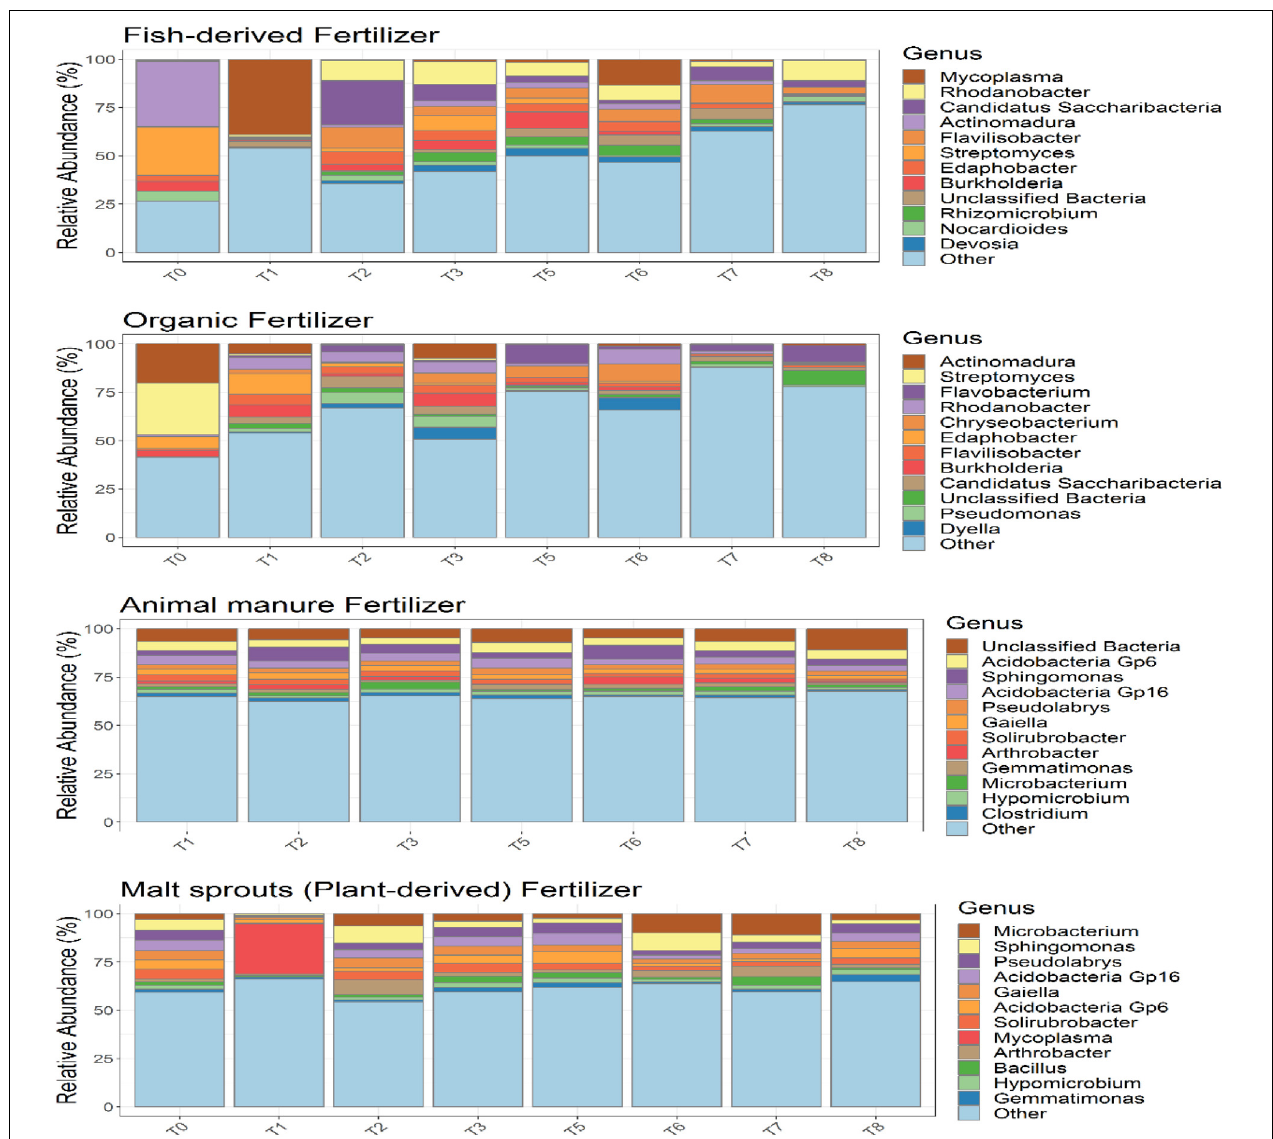
FIGURE 9 | Analysis of the bacterial composition of the different tomato cultivation systems: GBOF (organic fertilizer), GBFISH (fish derived fertilizer), SOILANIMAL (animal based fertilizer) and SOILPLANT (plant derived fertilizer). Relative abundance (percentages) of the different bacterial phyla (16S V3–V4 region) in the tomato bulk soil. Phyla representing less than 1% of the total community are bundled in the group “other”, as their taxonomic composition may be